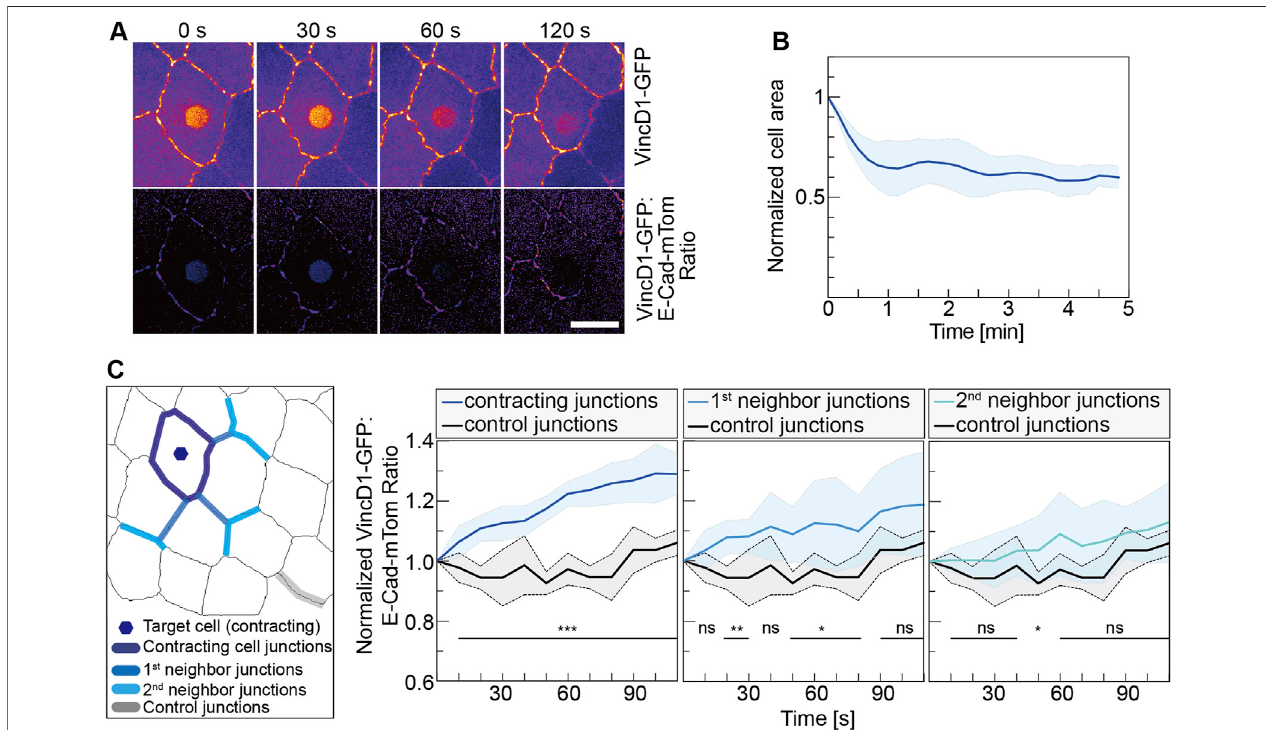
FIGURE 3 | Mechanical pull by a contracting cell is spread to neighbor junctions. (A) VincD1-GFP channel and ratiometric images from time-lapse recordings of embryos (stage 14, AS) expressing VincD1GFP and E-CadmTom after UV-laser illumination for 500 ms. (B) Time courses of normalized cross-sectional area and its derivative of the target cells ( N = 6). (C) Time course of the ratiometric VincD1-GFP signal averaged of junctions, as indicated in the scheme. Junctions are grouped into three categories: junctions ofthe targetcell ( N = 30), next to the target cell (primary, N = 18), and next-next tothe target cell (secondary, N = 18). Controls were the junctions( N =5)mostdistanttothetargetcellfrommoviesof fi veembryos.Curvesrepresentmean(boldline)withSD(ribbonband).Unpairedtwo-sided t -testestimates the p values, ns, not signi fi cant, * p < 0.05, ** p < 0.01, and *** p < 0.001. Scale bar, 10 μ m.